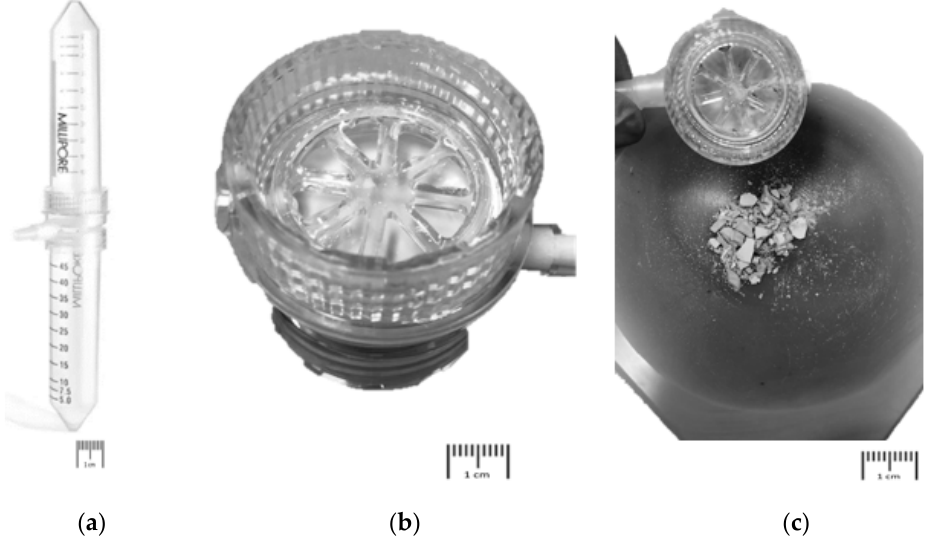
Figure 3. Vacuum-driven sterile filter technique. ( a ) Sterile disposable vacuum filter unit from MilliporeSigma. ( b ) Steriflip-GV Filter Unit as membrane filter with dried particles. ( c ) Separation of the rock particles from the filter and placed in an agate mortar.